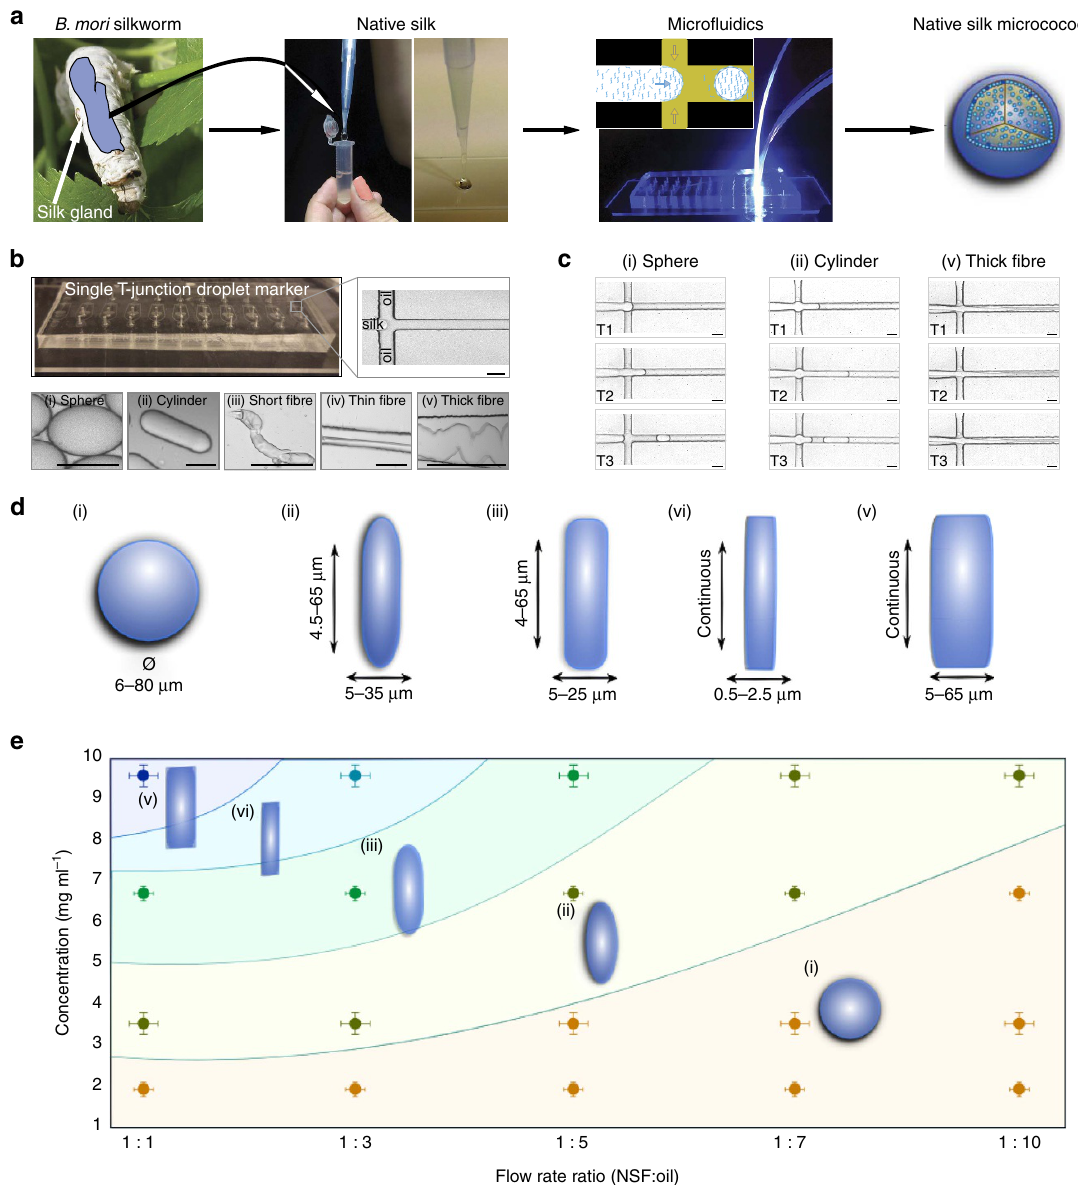
Figure 1 | Micrococoon synthesis. ( a ) Schematic representation of the microfluidic processing of NSF into micrococoons. ( b ) Optical microscopy images of the NSF micrococoons formed at a single T-junction in the microfluidic device. Micrographs of a variety of NSF micrococoon shapes are shown in the lower panels: (i) sphere, (ii) cylinder, (iii) short fibre, (iv) thin fibre, (v) thick fibre. Scale bar, 20 m m. ( c ) Micrographs of NSF micrococoon formation acquired at three different time points T1, T2 and T3: (i) sphere; T1 ¼ 0ms, T2 ¼ 10ms, T3 ¼ 13ms, (ii) cylinder; T1 ¼ 0ms, T2 ¼ 13ms and T3 ¼ 34ms and (v) thick fibre; T1 ¼ 0ms, T2 ¼ 59ms, T3 ¼ 68ms. Scale bar, 20 m m. ( d ) S schematic representations showing the characteristic dimensions of the NSF micrococoons generated in this study. ( e ) Different micrococoon shapes generated as a function of the protein concentration and of the ratio of the flow rates of the aqueous to oil